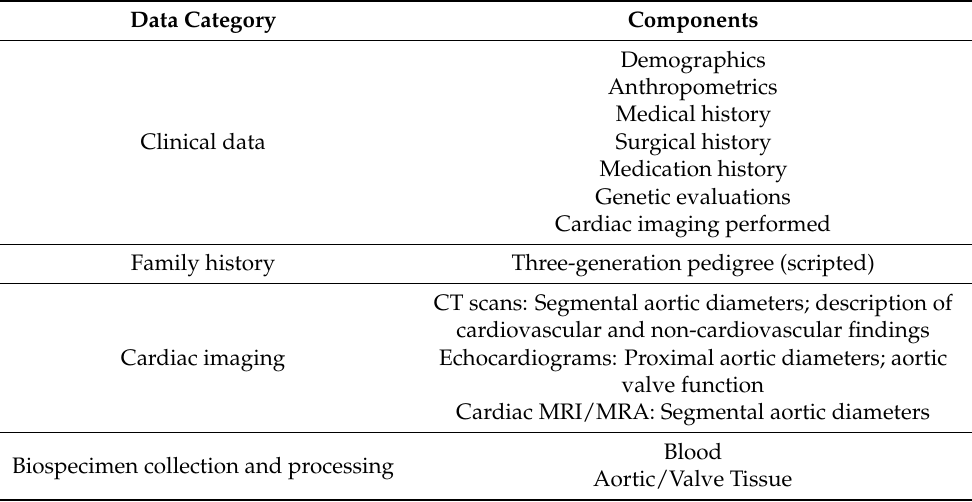
Table 1. Categories of data that are routinely entered in the CHAR